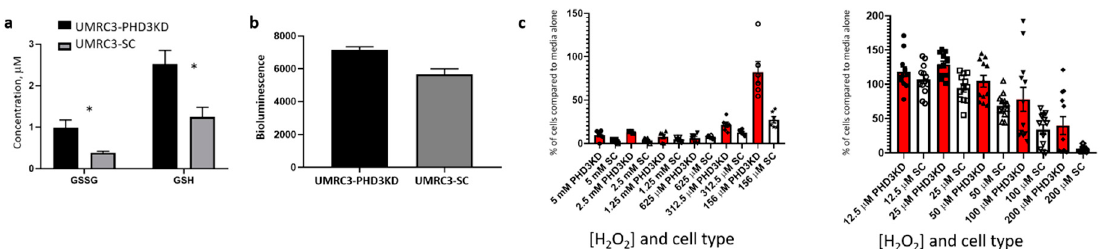
Figure 5. Redox changes by PHD3 knockdown. ( a ) Glutathione colorimetric detection revealed that UMRC3-PHD3KD tumors had significantly higher concentrations of GSH and GSSG than UMRC3-SC tumors (* p < 0.005). ( b ) UMRC3-PHD3KD and UMRC3-SC cells produce different levels of hydrogen peroxide measured by bioluminescence assay over a 24 h period (* p < 0.002). ( c ) UMRC3-PHD3KD cells have higher proliferation rates in the presence of H 2 O 2 than UMRC3-SC cells. Concentration of H 2 O 2 and cell type (PHD3KD versus SC) is shown on the in x-axis and percentage of cells in each well compared to media alone is displayed on the y-axis. In both cell types, few cells remain at H 2 O 2 concentrations higher than 312.5 µM. Significance differences in proliferation are observed in UMRC3-PHD3KD cells (red bars) versus UMRC3-SC cells (white bars) at 200, 156, 100, 50 and 25 µM H 2 O 2 concentrations ( p < 0.05).